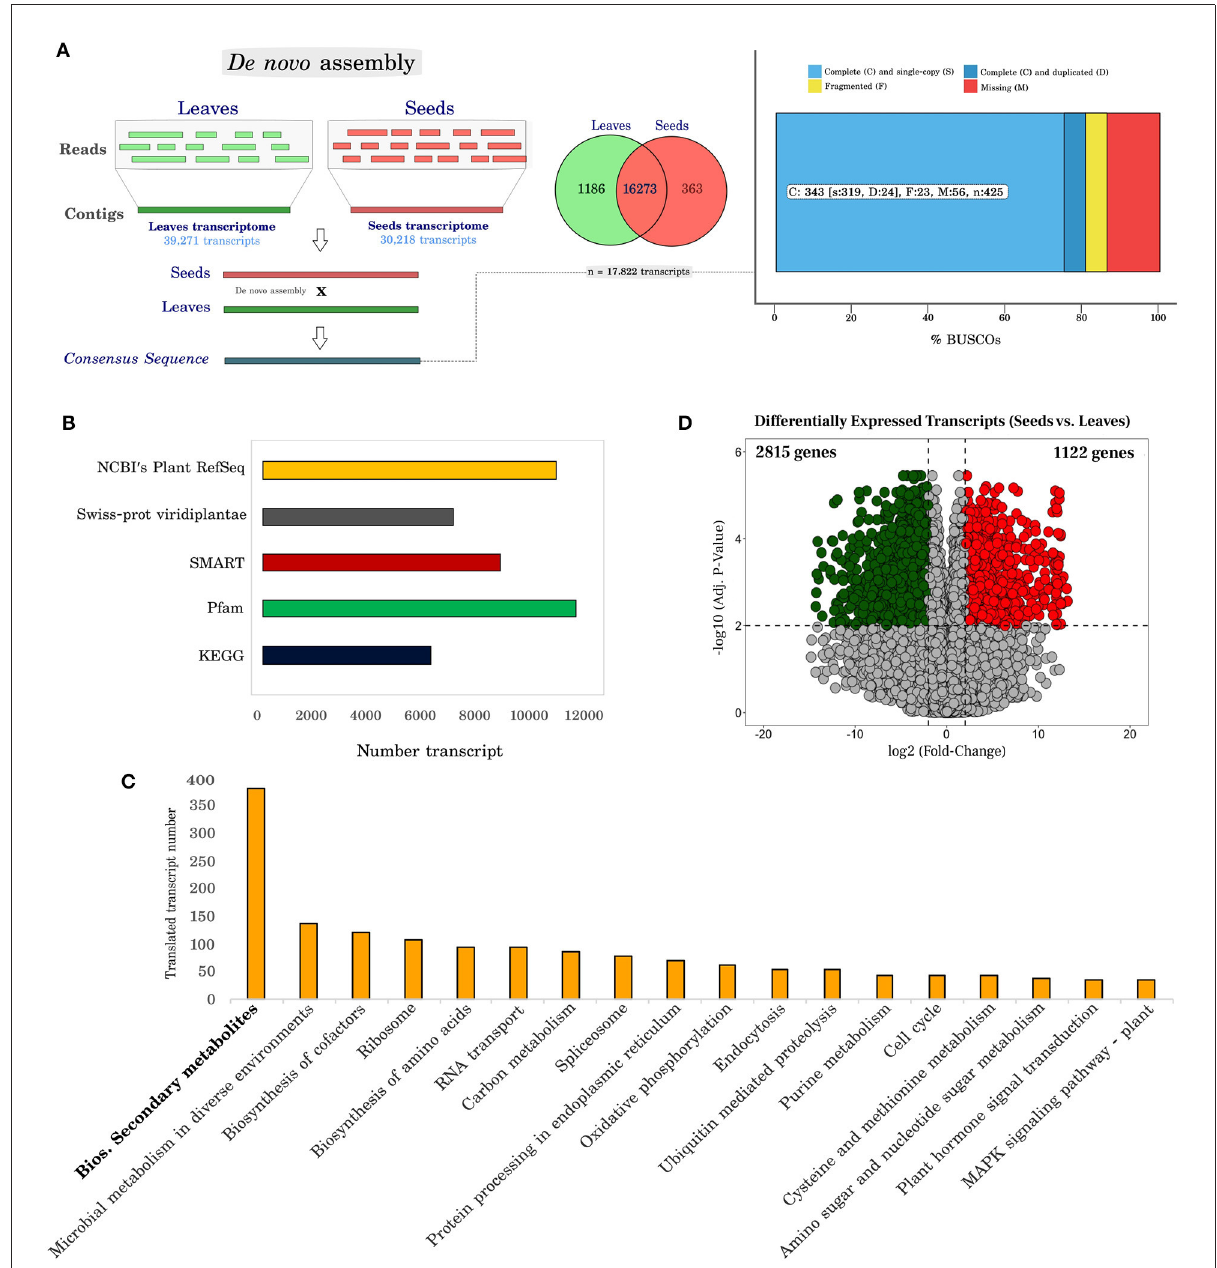
FIGURE2 Functional annotation and differentially expressed transcripts in Erythrina velutina . (A) Strategy to assemble cDNA libraries from leaves and seeds and analyses the genetic content of orthologs using the BuscoV3 tool. The raw files of each individual lane were used for the sequence assembly step, using Trinity software. The FASTA files resulting from this process were then constructed hierarchically to form pool sets (collection of different populations), and later tissues (leaves and seeds), according to the scheme in Supplementary Table 2. The genetic completeness of the transcriptome using BUSCO is given as a percentage after analysis against the viridiplantae_odb10 database. In this analysis the X axis represents the cDNA library (leaves and seeds, combined; or separate leaves and seeds, [see Supplementary Figures 2, 3]), while the Y axis represents the percentage of complete, fragmented, and lost sequences in our analyses. After gathering the sequencing data from E. velutina leaves and seeds, 847 orthologs distributed in 425 groups were found in the dataset. Furthermore, with regard to the total representation of the analyzed transcripts, 343 ( ∼ 80%) of the sequences were complete, 23 ( ∼ 10%) fragmented and 56 ( ∼ 5%) missing; (B) Number of transcripts annotated in the different databases used in this analysis; (C) Number of transcripts identified and distributed in the main identified metabolic pathways using The Kyoto Encyclopedia of Genes and Genomes (KEGG) tool; (D) Volcano plot representative of differentially expressed transcripts. The Y axis represents the adjusted p -value, and the X axis, fold change (log 2 ). Up-regulated and down-regulated genes are red and green,